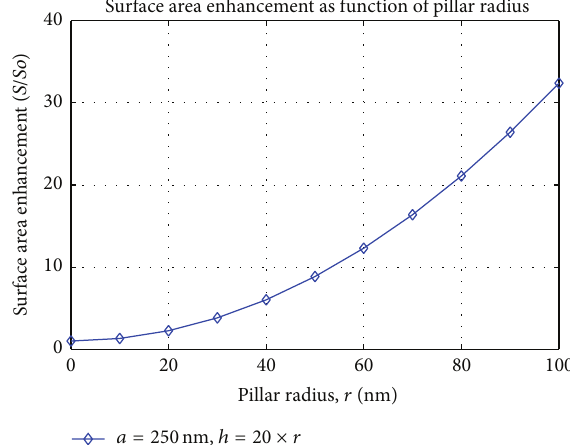
Figure 3: Surface area enhancement due to